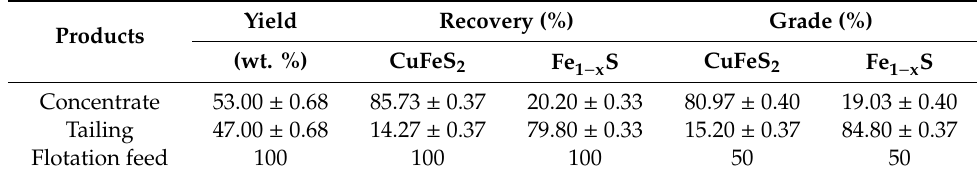
Table 2. Selective flotation results of the binary mixed chalcopyrite and pyrrhotite at 50 mg / L PGA, 20 mg / L SBX, and pH 8.